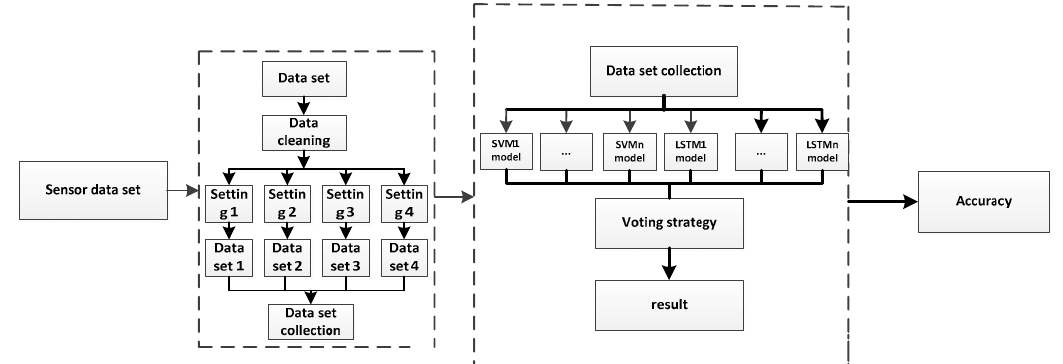
Figure 3. Improved Long Short-Term Memory (LSTM) and Support Vector Machine (SVM) (ILS) Flow Chart.